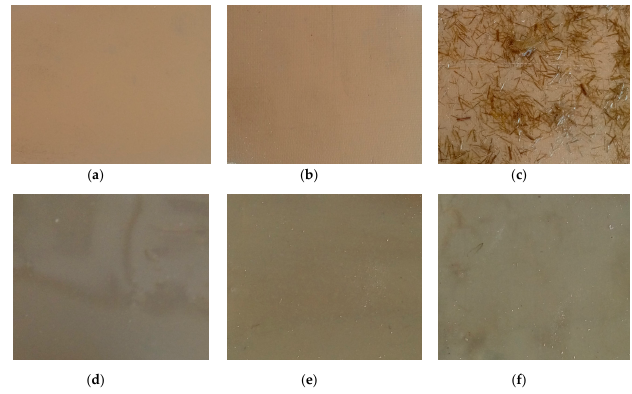
Figure 2. Images of the obtained surfaces: ( a ) EP; ( b ) EP_GF; ( c ) EP_GF_HF; ( d ) EP_PUA; ( e ) EP_GF_PUA; ( f ) EP_GF_HF_PUA.